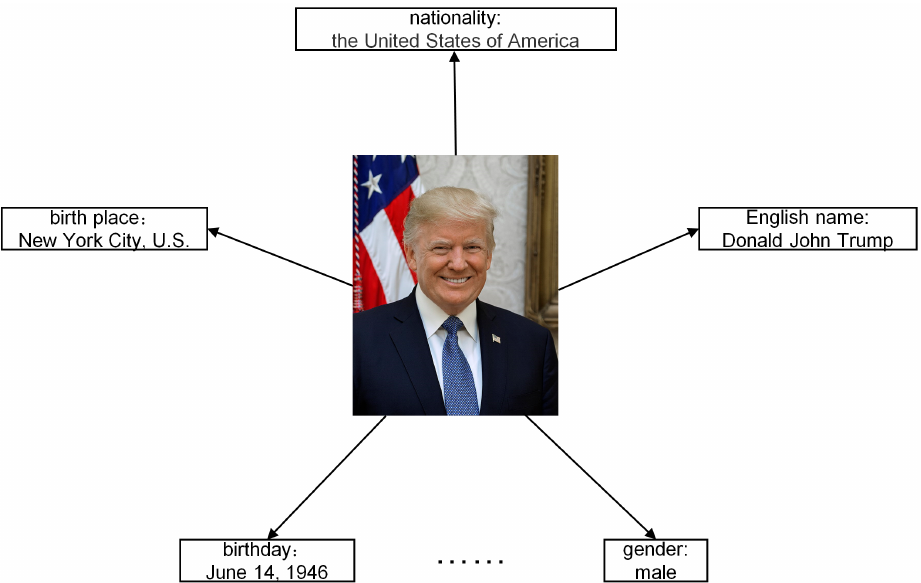
Figure 2. The example of the entity attribute graph for the entity “Donald